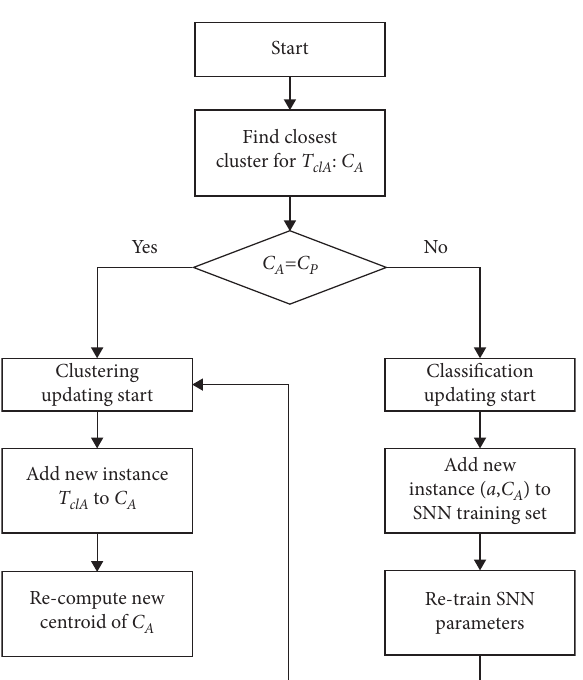
Figure 11: Clustering and classification updating process.